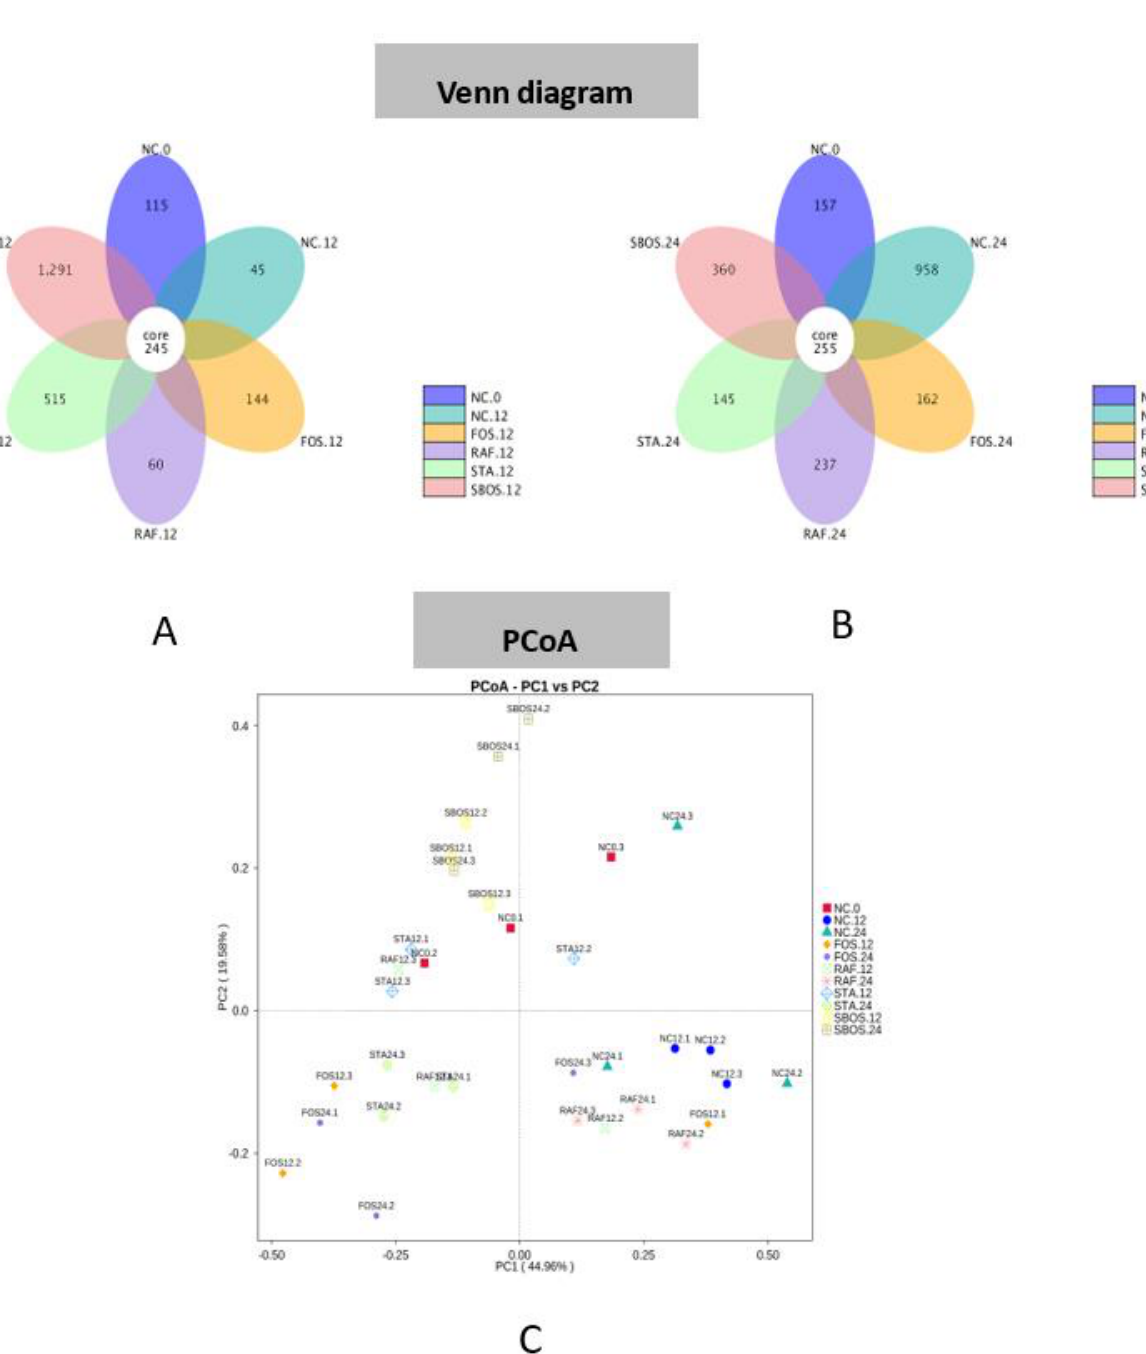
Figure 6. Venn diagram of OTUs at 12 ( A ) and 24 h ( B ) of fermentation and PCoA analysis ( C ) of gut microbiota based on weighted unifrac distance.